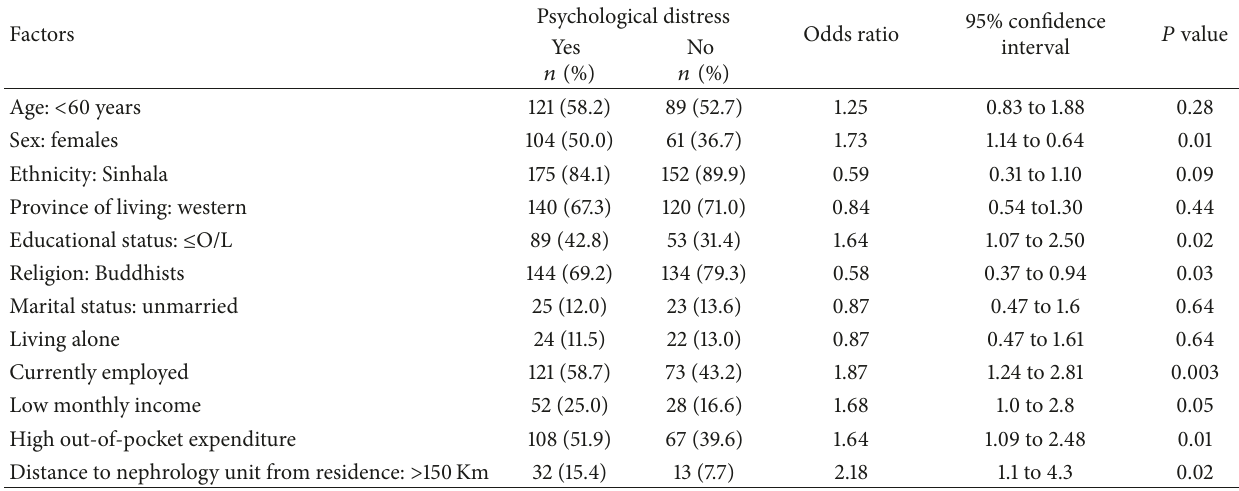
Table 2: Unadjusted odds ratios of demographic and economic factors and psychological distress.